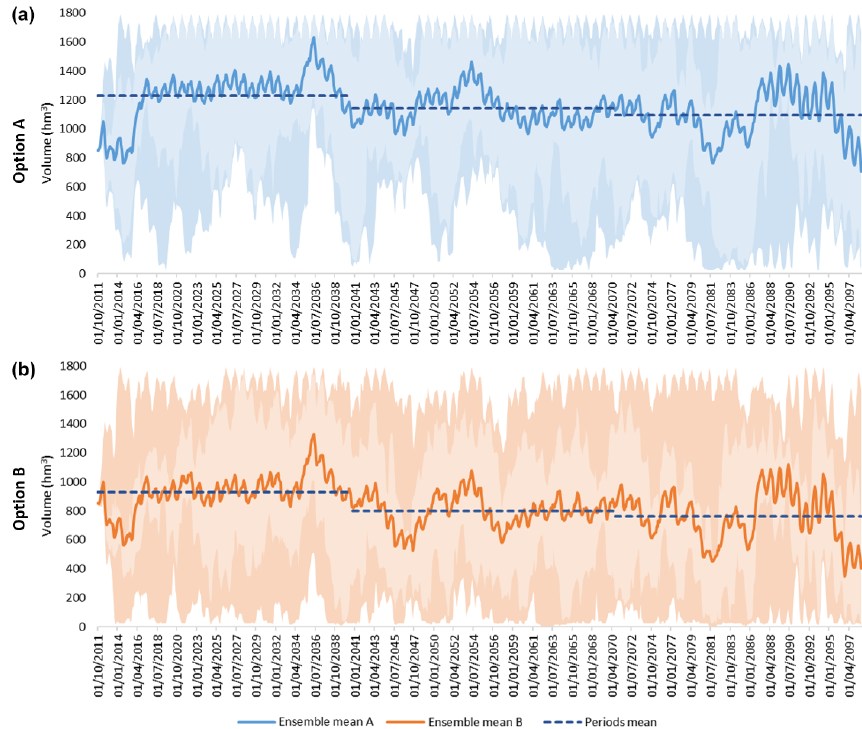
Figure 7. Evolution of the water storage in the Júcar WRS for the ensemble of options A (a) and B (b) in the future period 2011–2098.